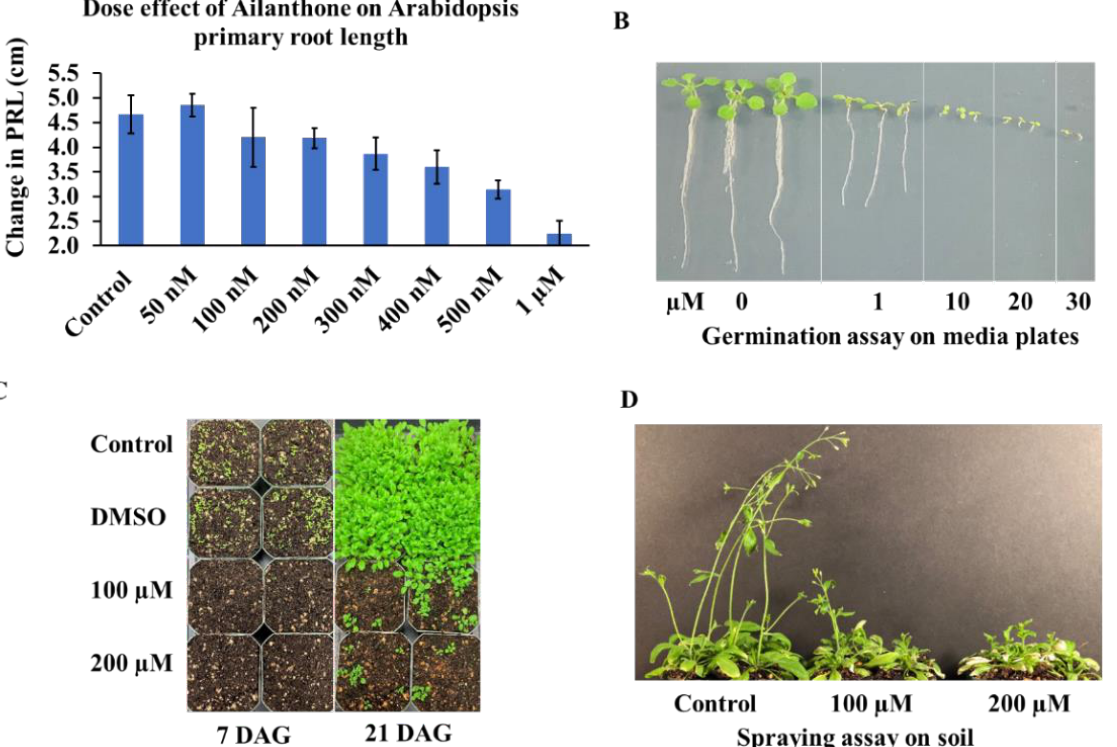
Figure 1. Effect of ailanthone on Arabidopsis primary root growth and seed germination. Seven- day-old Col-0 seedlings were transferred to media plates supplemented with different ailanthone concentrations. Change in root growth was quantified on day 7 after the onset of the treatment ( p < 0.001) ( A ). Arabidopsis seeds were germinated in vitro on growth media supplemented with 1–30 µM ailanthone and representative germinated seedling images are presented ( B , C ) Col-0 seeds were germinated and grown on ailanthone-treated soil for 7 and 21 days. The top soil was sprayed with or without ailanthone (DMSO as a mock and control, no DMSO). Representative images were taken at 7 and 21 days after germination (DAG). ( D ) Seedlings were grown to maturity shown in ( C ). Representative photos were taken at 50 DAG.